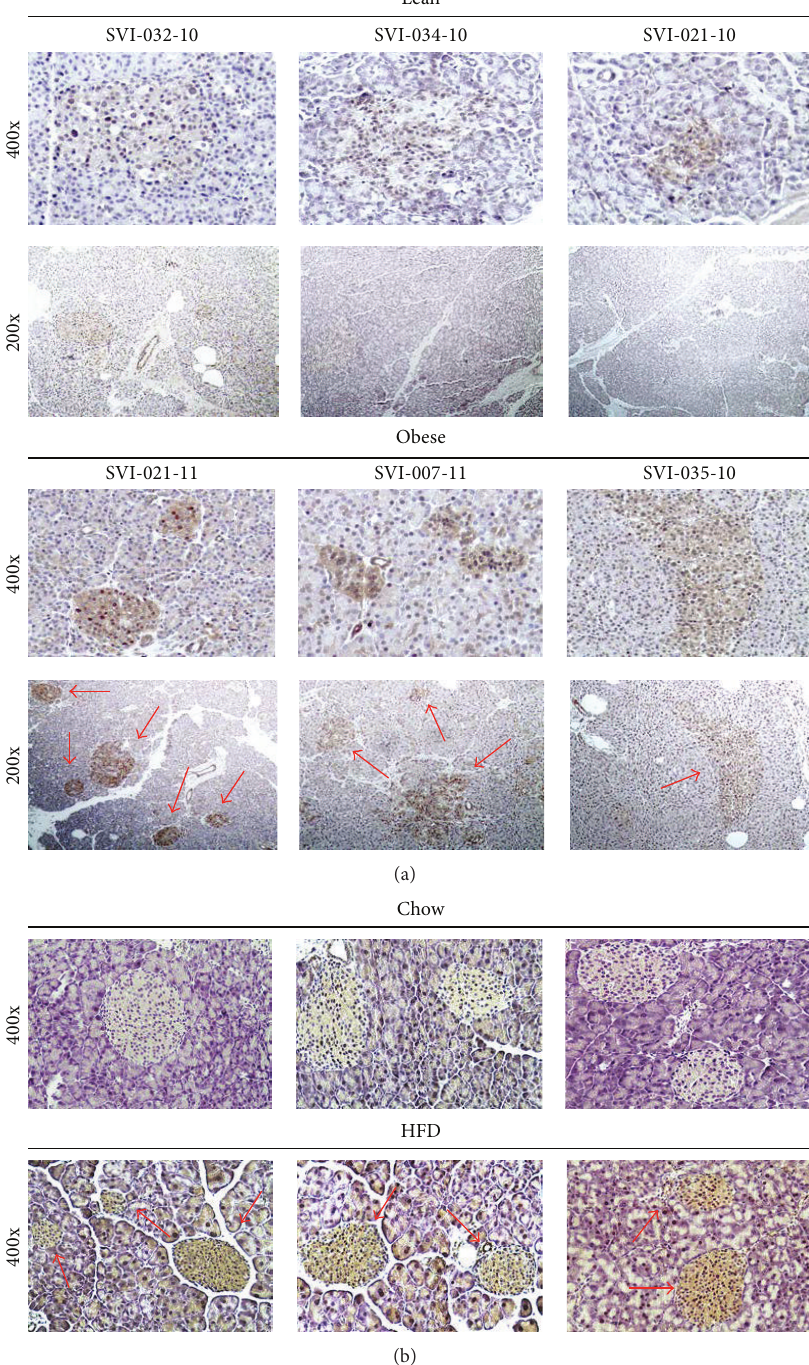
Figure 1: Immunohistological images of pancreas slides stained for ubiquitin in lean and obese humans and chow and high fat fed mice after 24 weeks. (a) Pancreases were obtained from human organ donors and then were embedded in paraffin and cut into 5 𝜇 m thick sections. Immunohistochemistry was then performed, staining for ubiquitin. (b) Pancreatic sections from mice fed chow or on high fat diet for 24 weeks were stained for ubiquitin. Red arrows indicate islets with higher levels of ubiquitinated protein ((a) and